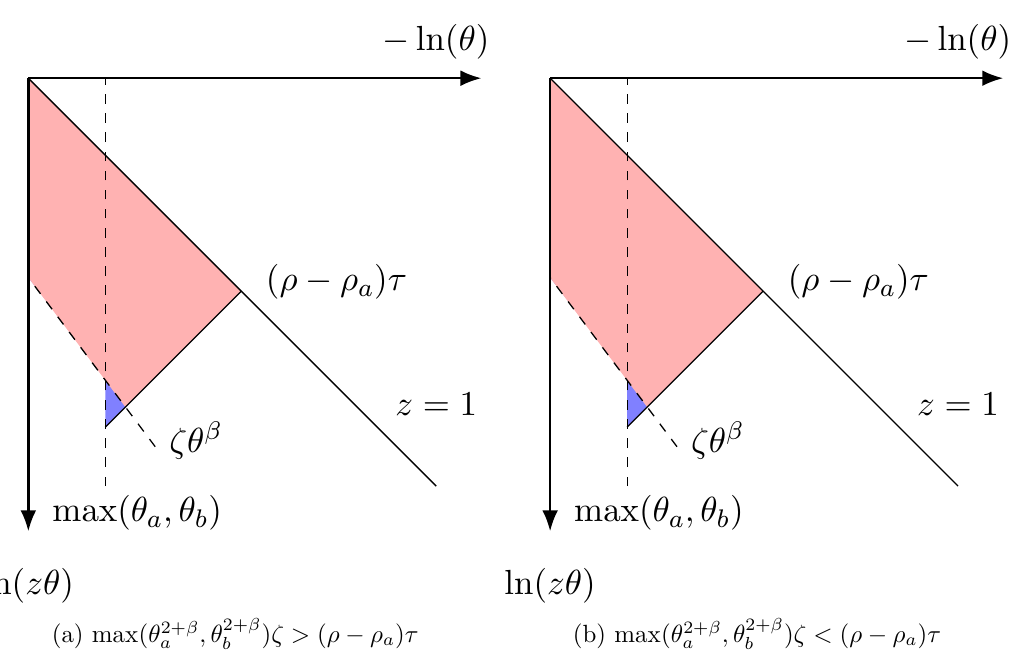
Figure 2. Lund diagrams showing the region of phase space vetoed for jets which are groomed with Soft Drop and tagged with Y m -Splitter and a cut on τ 32